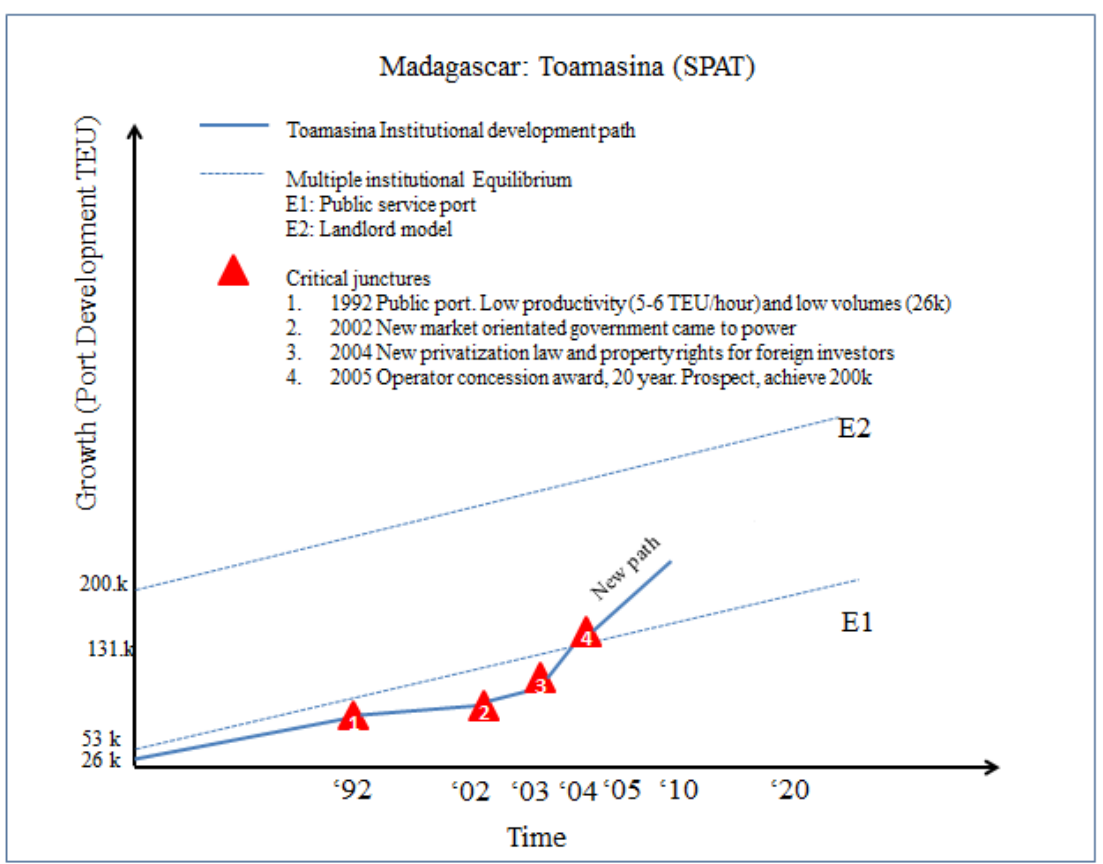
Figure 6. Institutional development path of Toamasina At juncture 1, unsustainable low productivity and low volumes were generated at Toamasina which operated within a public service port institutional equilibrium path (E1). The election of a new market orientated government in 2002 (juncture 2) resulted in new privatization laws and property rights for foreign investors (juncture 3). This presented the opening of a window of opportunity for port investment which culminated in the conclusion of a private operator concession agreement and the shift to a new institutional equilibrium path